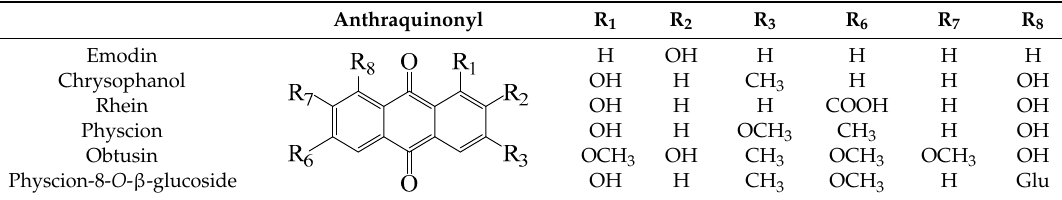
Table 1. Representative anthraquinones isolated from Semen Cassiae and their molecular structures.